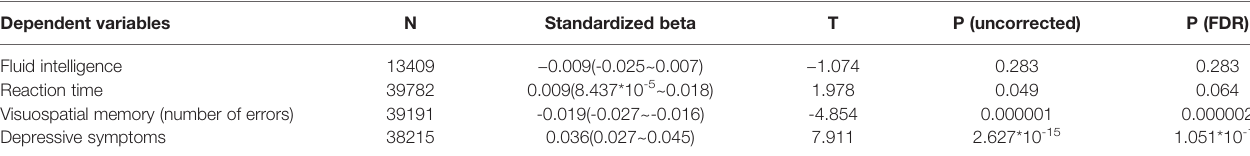
TABLE 2 | Statistical values describing associations between BMI and longitudinal changes in psychological measures (longitudinal multiple regression